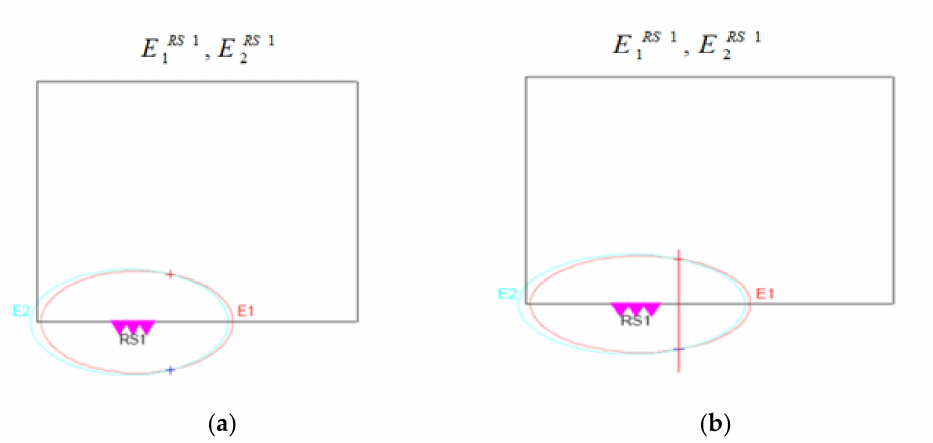
Figure 2. Intersections of RS1